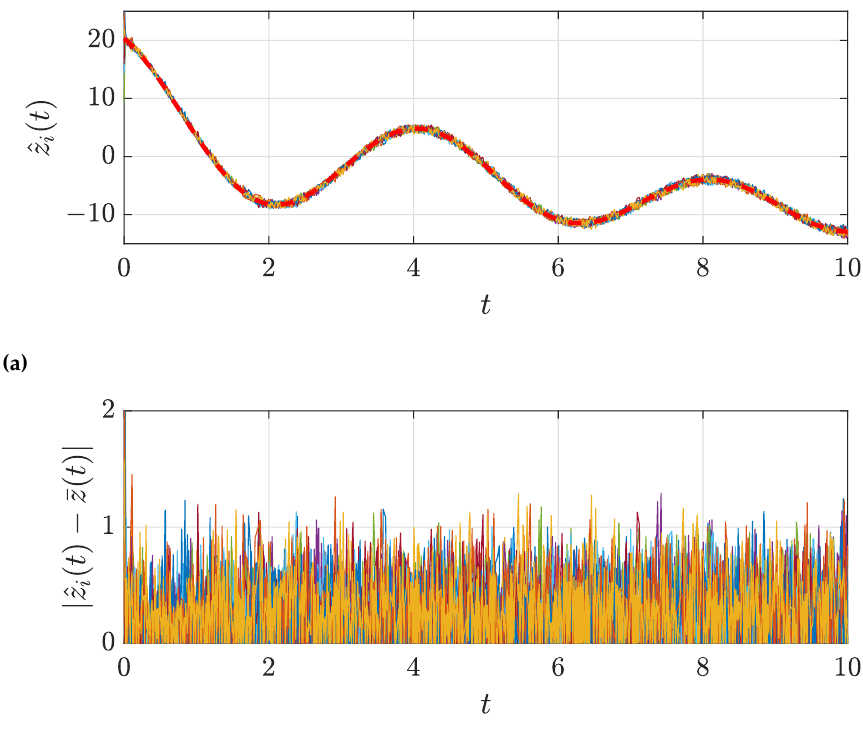
Figure 5. Consensus results for our protocol with ∆ = 10 − 4 , ε = 1. Due to the increase in the event- triggering threshold, the error is higher than in the case with ε = 0.01, shown in Figure 4. ( a ) Consensus estimates for the average signal using our proposal. The desired value ¯ z ( t ) is plotted as a dashed red line. The estimates quickly converge to the average signal, but with an increased steady-state error due to the event-triggered communication. ( b ) Consensus error of the estimates with respect to the average signal. Increasing the event-triggering threshold ε causes a higher steady-state error.